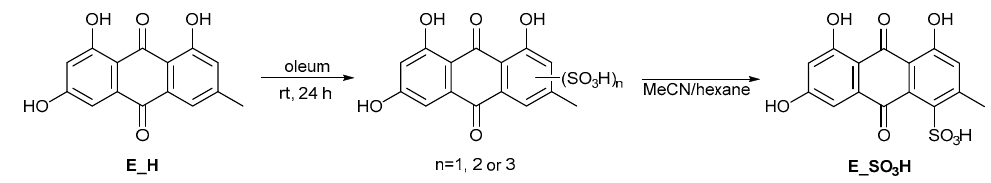
Figure 3. Synthesis of E_SO 3 H .